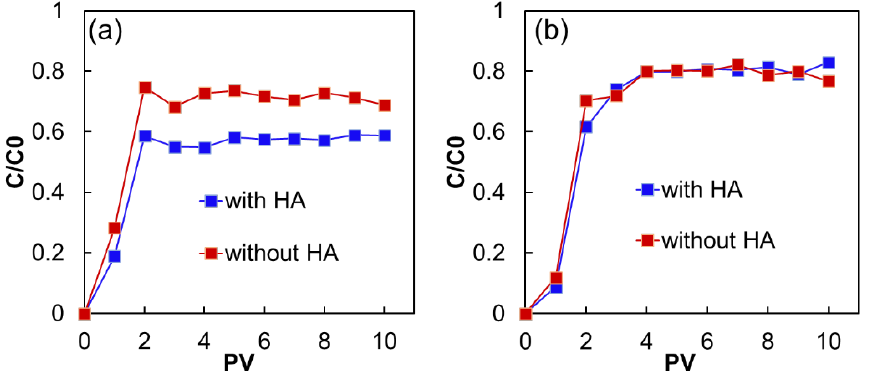
Figure 7. The effect of HA on Ni 2+ transport in the sand column. ( a ) In the presence of soil colloids; ( b ) in the absence of soil colloids. The initial concentration of Ni 2+ was 0.6628 mg·L −1 , the concentrations of soil colloids and HA were 220 and 20 mg·L −1 , respectively; IS = 0 mmol·L −1 .